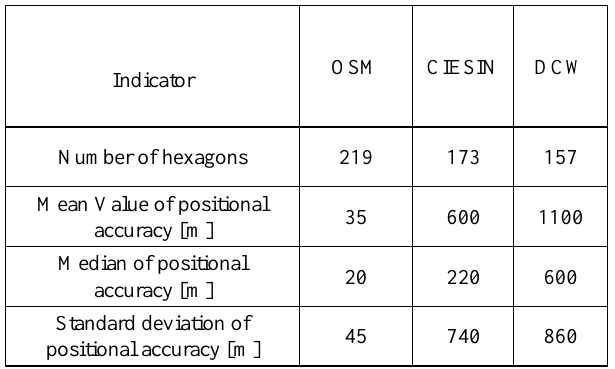
Table 4. The basic statistics of positional